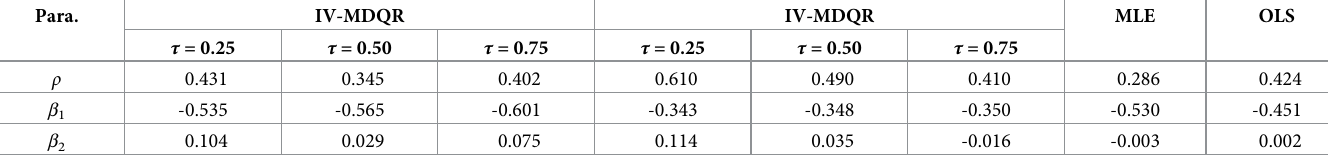
Table 5. Estimation results of cigarette demand based on spatial autoregressive panel data models.